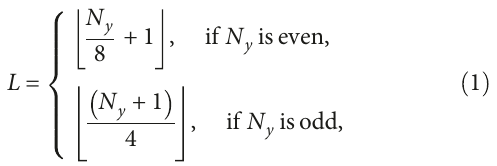
Figure 1: (a) Array geometries of the hourglass array [11] and (c) thermos array (normalized by d ) in which N total number of sensors is K = 67 . (b) The resulting DCA of the hourglass array and (d) resulting DCA of the thermos